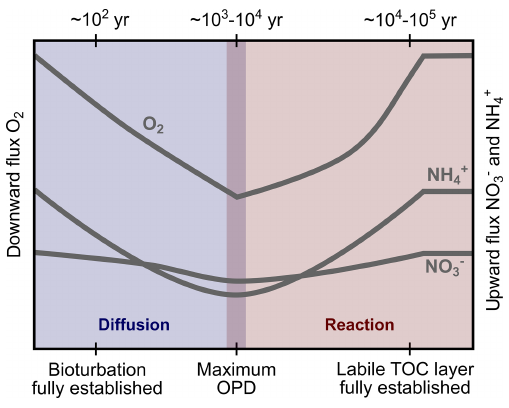
Figure 8. Conceptual model for time-dependent pore-water fluxes of oxygen (O 2 ), nitrate (NO − ) and ammonia (NH + ) at the 3 4 sediment–water interface after the removal of the upper 7–10cm of the sediments. The re-establishment of bioturbation, the maxi- mum oxygen penetration depth (OPD) and the re-establishment of the surface sediment layer dominated by the reactive labile organic matter fraction are indicated as a function of time after the sediment removal (years: